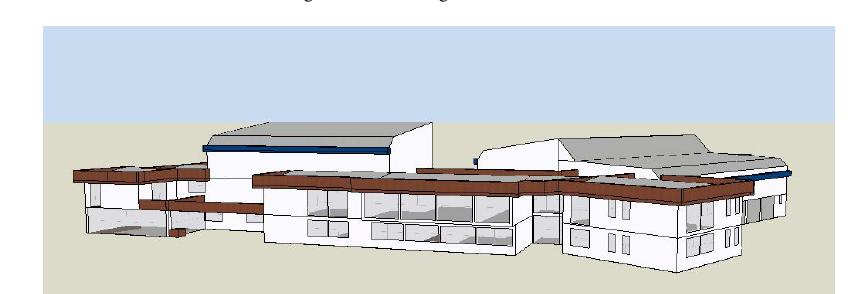
Figure 2. Building Northeast view